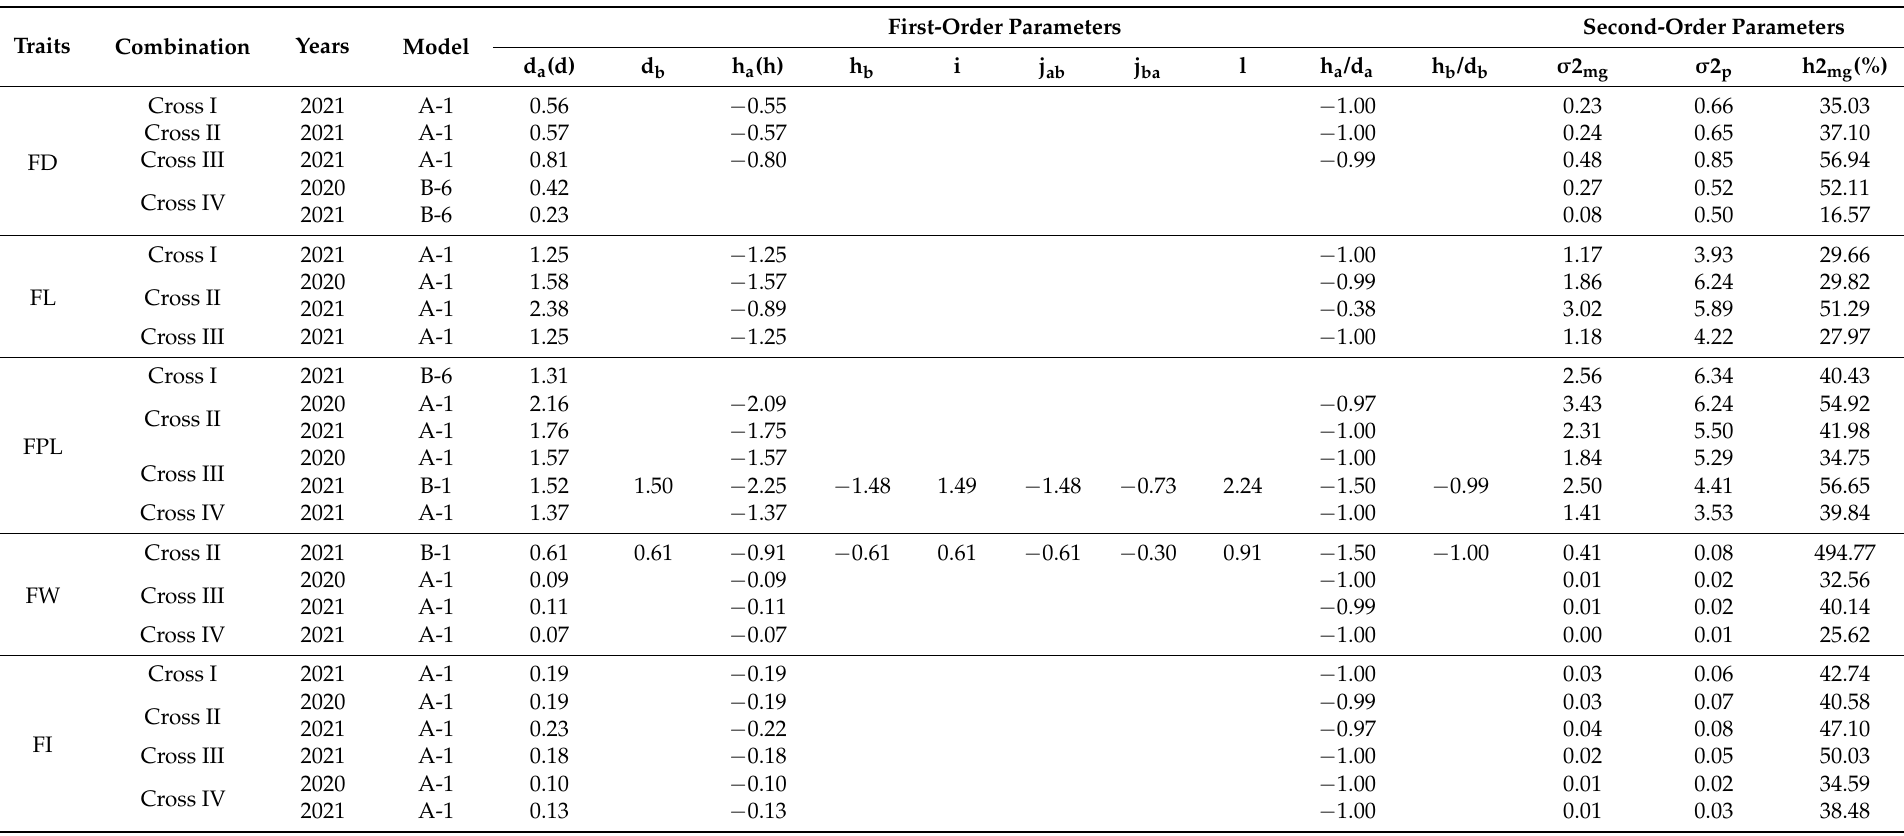
Table 6. The main gene heritability of five fruit traits in F 1 hybrids from four